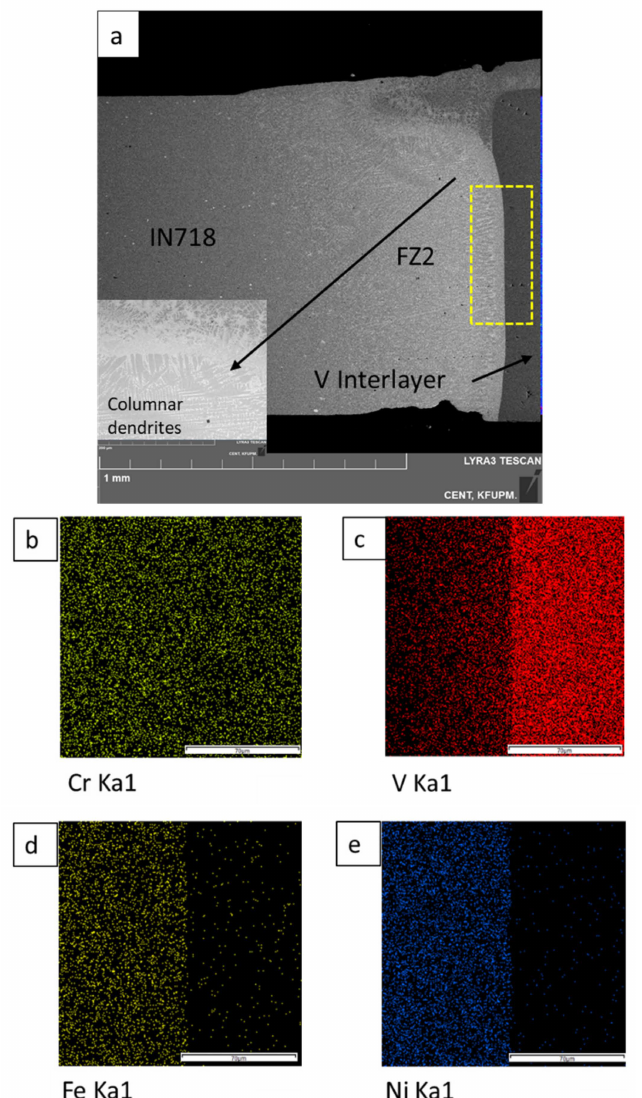
Figure 3. ( a ) Interfacial microstructures of V/IN718. Inset in ( a ) is a magnified image of the region indicated with the arrow. Elemental mapping of the region shown in ( a ) for ( b ) Cr, ( c ) V, ( d ) Fe, and ( e )